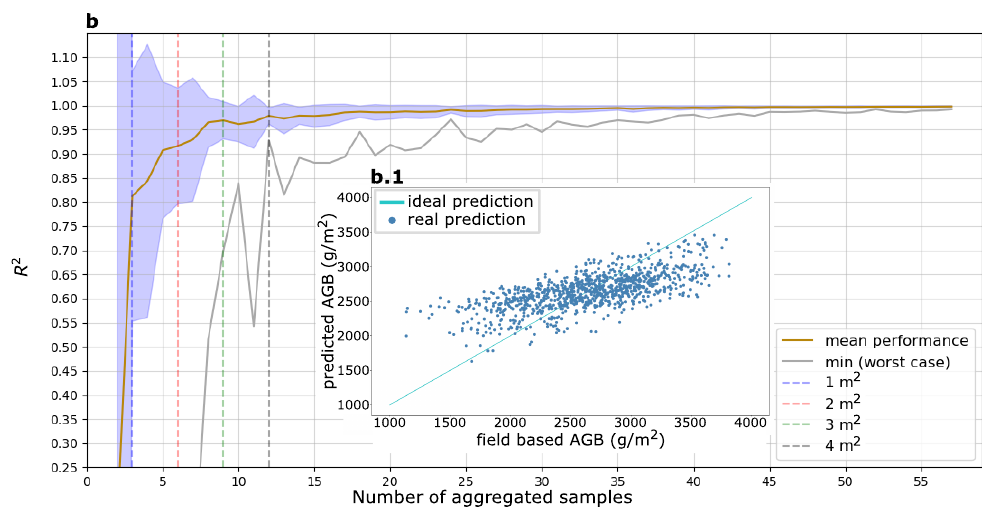
Figure 12. An analysis of the aggregated predictions using the barley testing dataset: ( a ) the residual distribution had a mean value approaching zero (i.e., 2.2 g/m 2 in the testing set, where N = 57); ( b ) the R 2 score converged to 1 as the number of aggregated samples increased. At every step along the x -axis, the data series took the mean (green solid line) of 100 repetitions (at a 1 m 2 spatial resolution, where R 2 = 0.71). The light gray line shows the worst performance in each iteration, while the shaded area covers the confidence interval (i.e., ± the standard deviation); ( b.1 ) a scatter plot of the predicted AGB values vs. the AGB field measurements at a 1 m 2 spatial resolution.